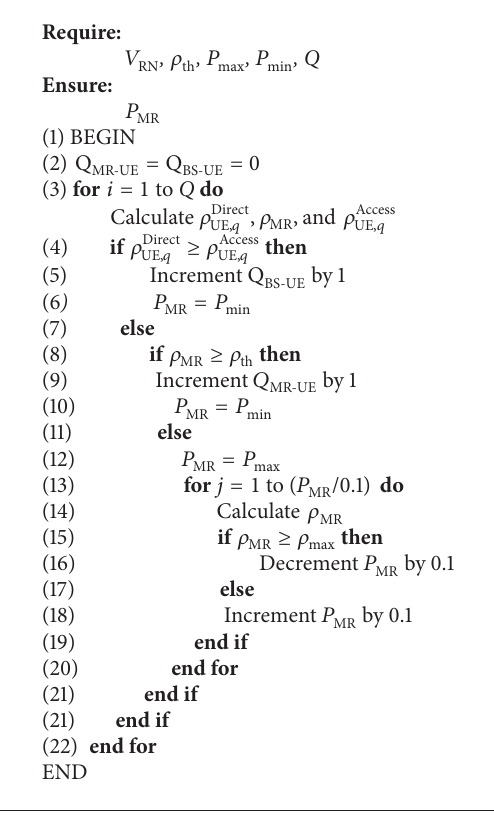
Algorithm 1: Balancing power algorithm of reducing and balancing of transmitted power consumption at